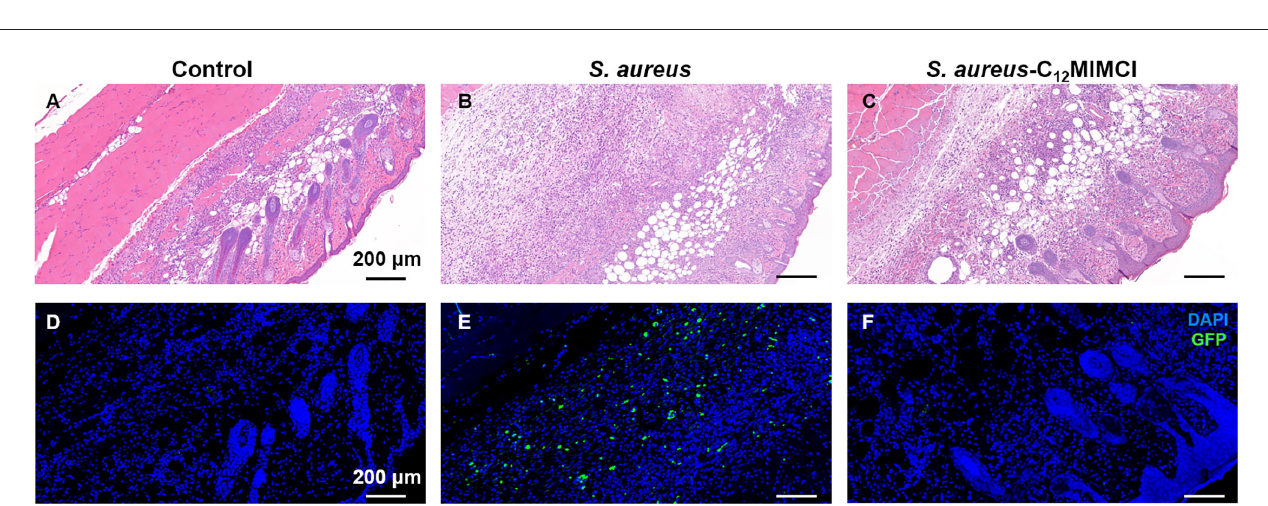
the broken cell membrane (Figure 6B). Then, the cell membrane of